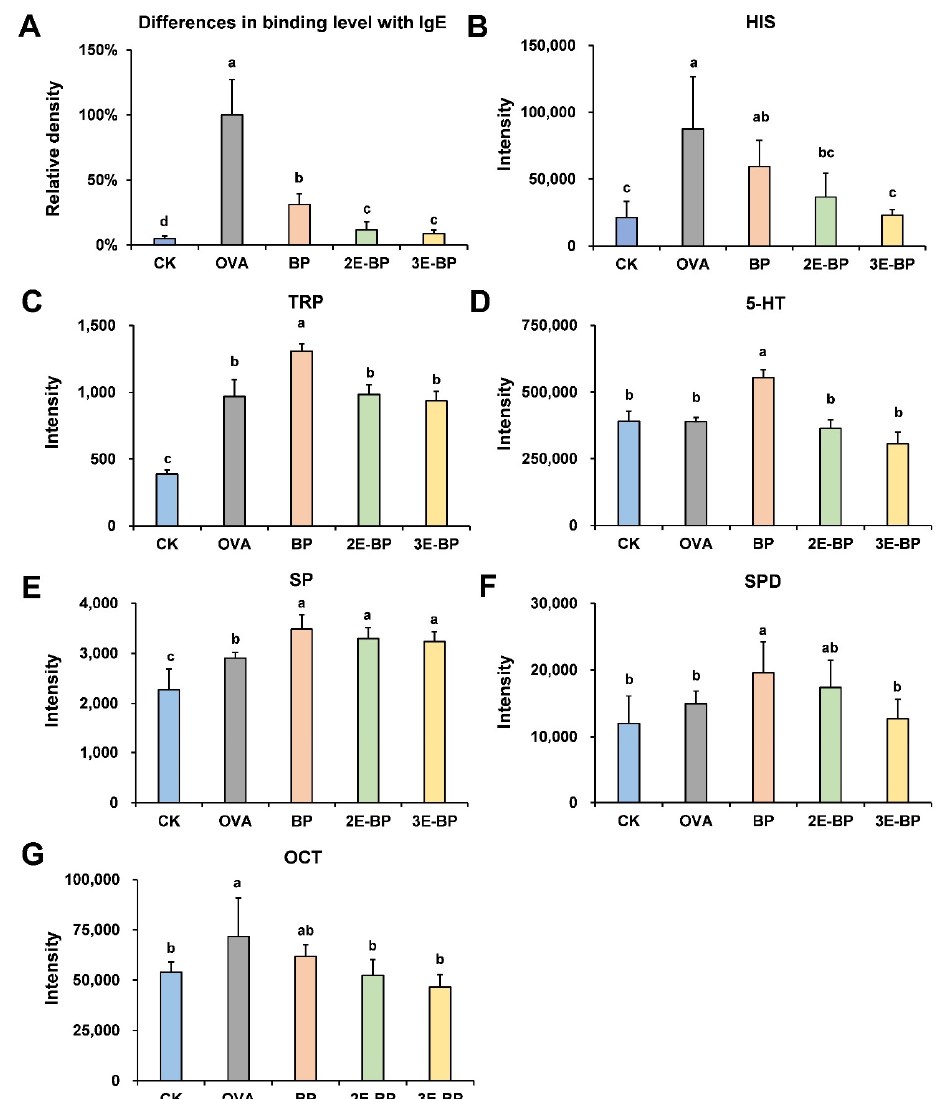
Figure 3. Changes in allergic mediators including IgE antibody ( A ), histamine ( B ), tryptamine ( C ), serotonin ( D ), spermine ( E ), spermidine ( F ) and octopamine ( G ) in mice serum of different treatment groups. Different letters indicate a significant difference among different groups ( p < 0.05).